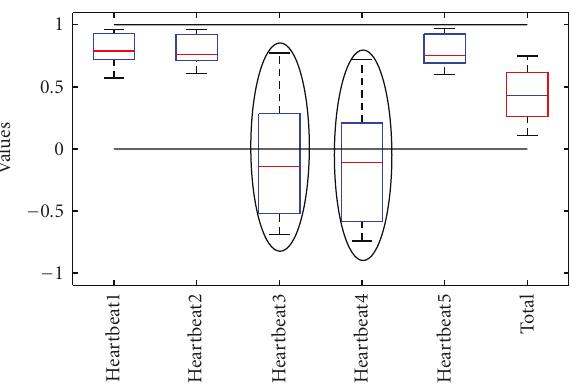
Figure 15: Boxplots of the correlation coe ffi cients, obtained for a patient with cardiac arrhythmia, between ECG and ECGR for each heartbeat and for the 12 ECG